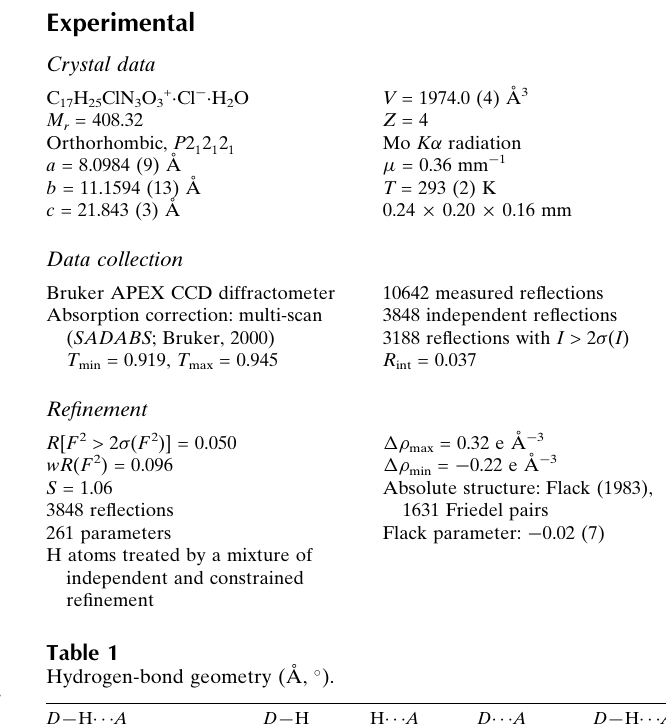
Bruker APEX CCD diffractometer Absorption correction: multi-scan